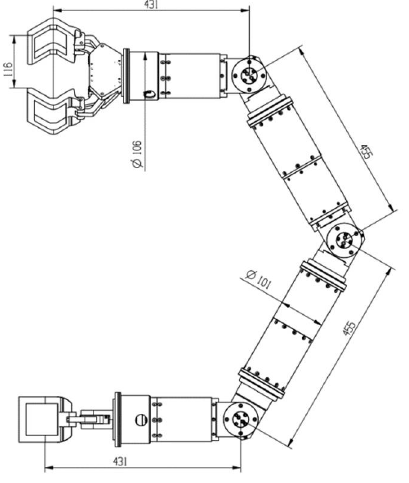
Figure 6. Inchworm robot parameter diagram.